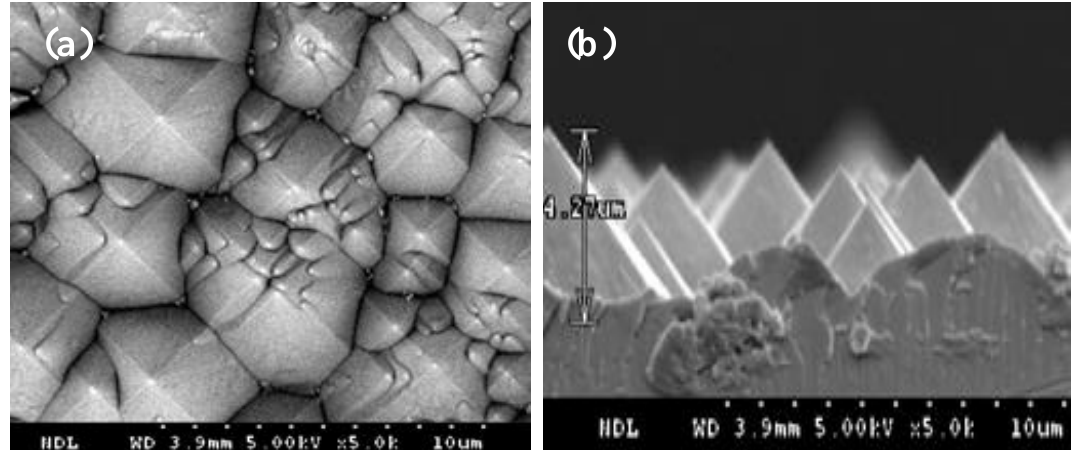
Figure 3. The SPTB layer/p-type Si(100) substrates were textured in 1.7% KOH solution for 25 min. ( a ) the surface morphology and ( b ) the cross-section image of the p-type Si(100) substrate without a SPTB layer was detected by